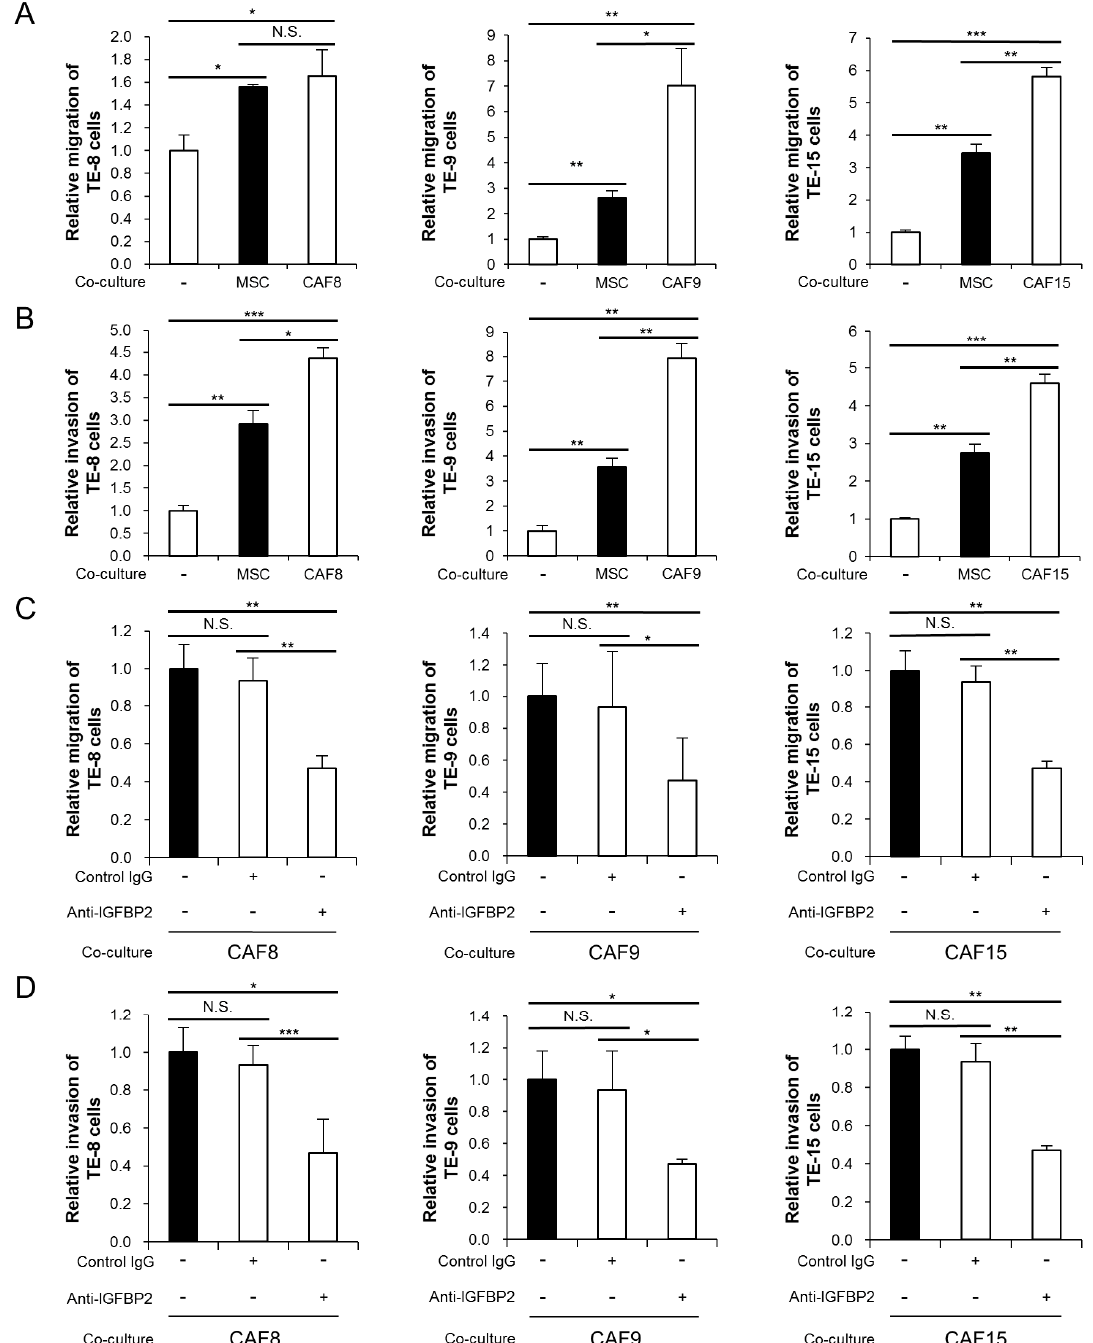
Figure 3. Anti-IGFBP2 neutralizing antibody suppressed the CAF-like cell-induced migration and invasion in three esophageal squamous cell carcinoma (ESCC) cell lines. ( A , B ) Transwell migration ( A ) and invasion ( B ) assays of TE-8, TE-9, and TE-15 ESCC cell lines co-cultured with MSCs or CAF-like cells compared with those of monocultured ESCC cells. Migrating and invading cells on the bottom of the upper chamber were counted in five randomly selected fields. ( C , D ) Transwell migration ( C ) and invasion ( D ) assays of ESCC cell lines co-cultured with CAF-like cells and with the anti-IGFBP2 neutralizing antibody or control goat IgG antibody, compared with those without antibody. Migrating and invading cells on the bottom of the upper chamber were counted in five randomly selected fields. Data are presented as mean ± SEM (* p < 0.05, ** p < 0.01, *** p < 0.001, N.S. not